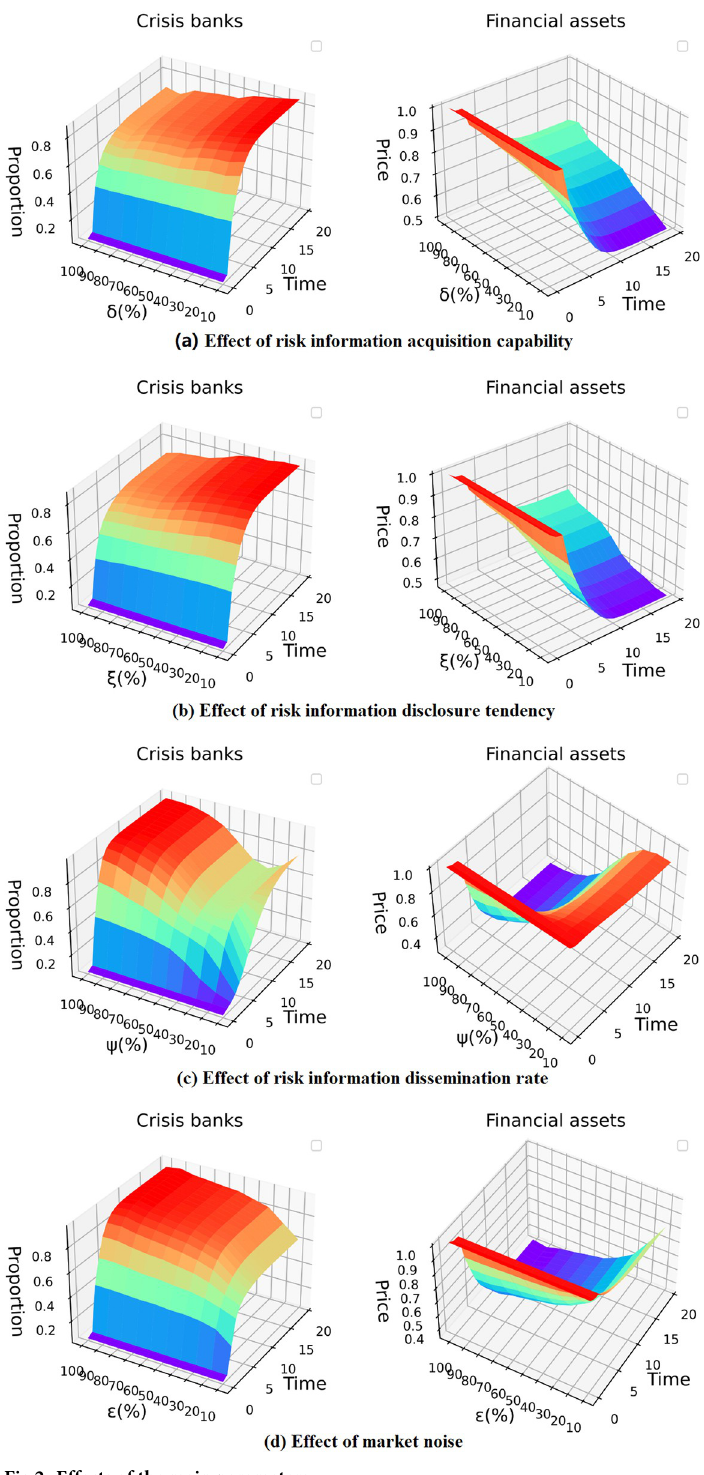
Fig 2. Effects of the main